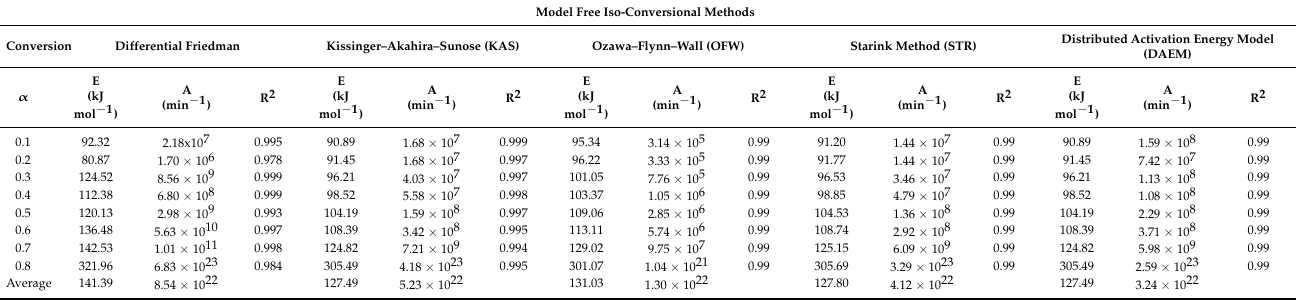
Figure 3. Activation energy vs the conversion plot of ( A ) PET ( B ) GDC + PET ( C ) GDC. Table 3. Activation Energy and the pre-exponential factors for the groundnut residue.